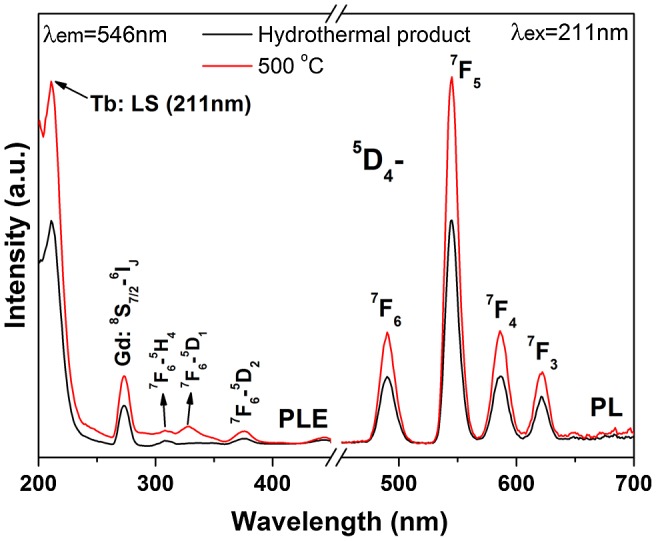
PLE and PL spectra of (Gd0.95Tb0.05)PO4·nH2O and its product calcined at 500 °C.